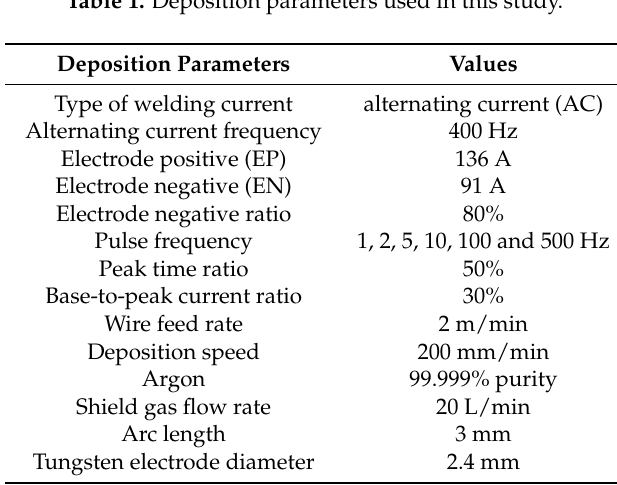
Figure 1. Schematic of the experimental setup developed for wire arc additive manufacturing. Table 1. Deposition parameters used in this study.